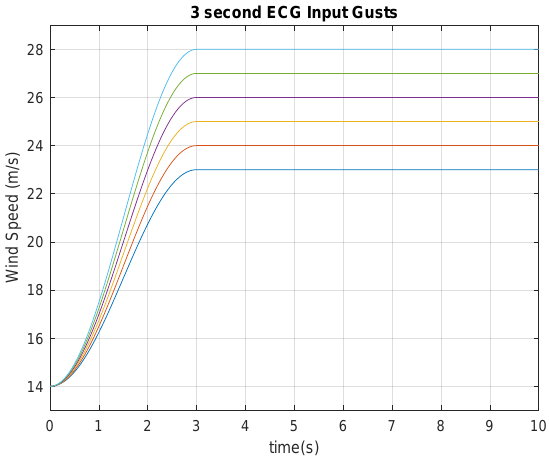
Figure 9. 3 s ECG test gusts